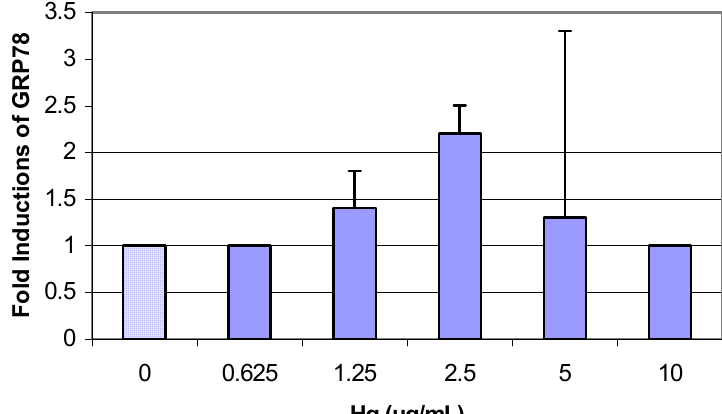
Figure 9. Fold induction of GRP78 in HepG means ± SDs, n =